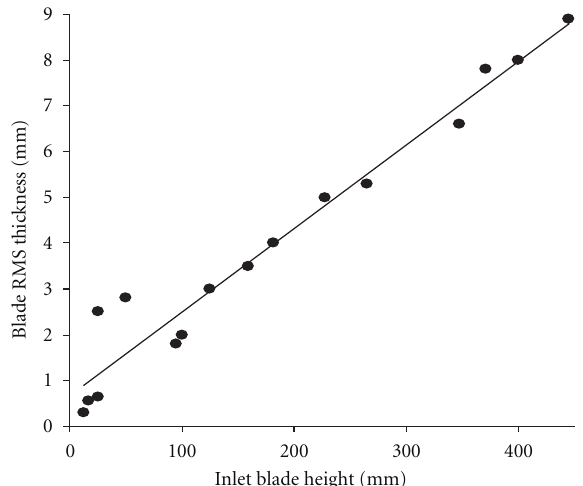
Figure 8: Relationship between impeller inlet RMS thickness and inlet width.